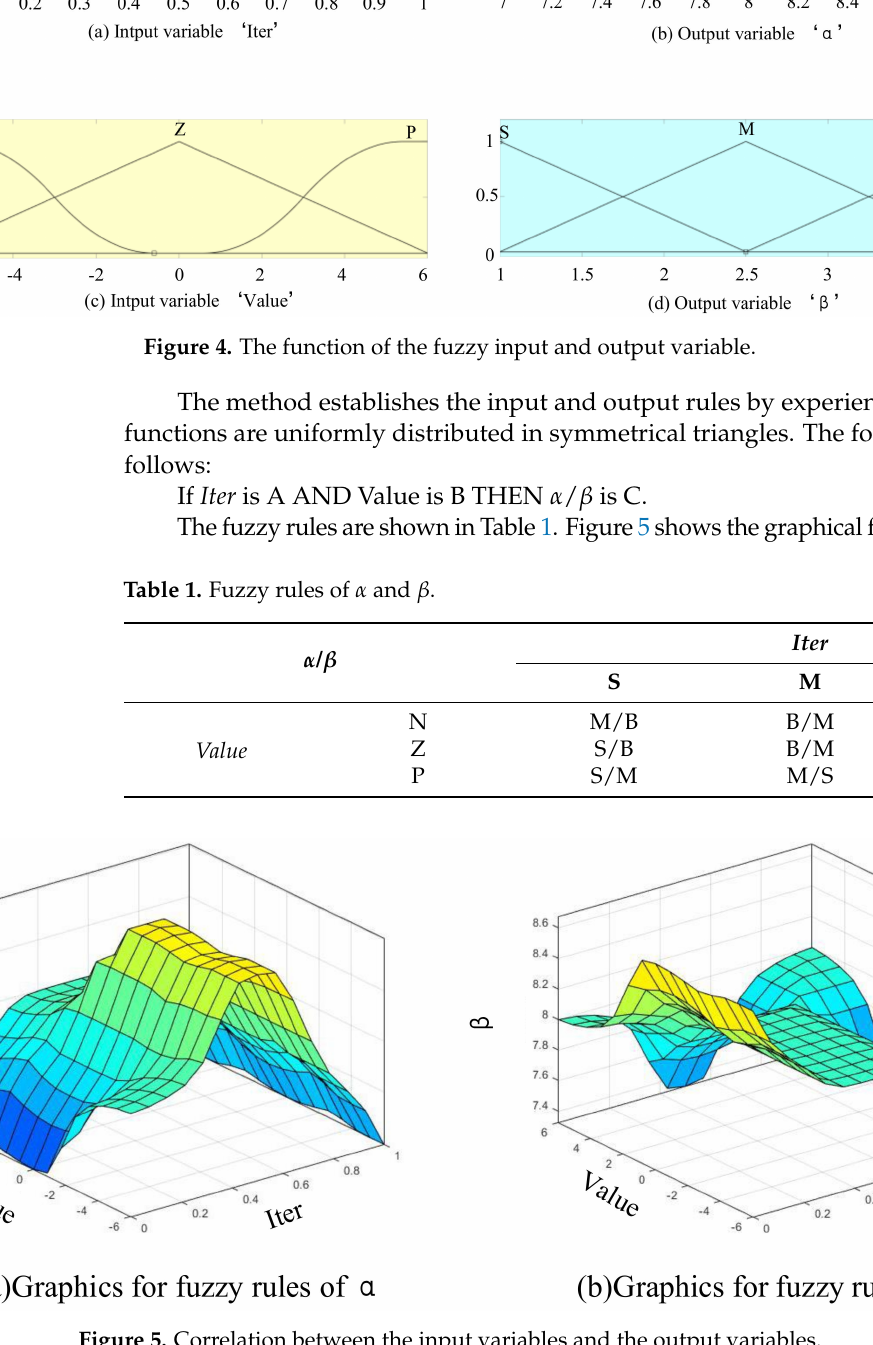
Figure 5. Correlation between the input variables and the output